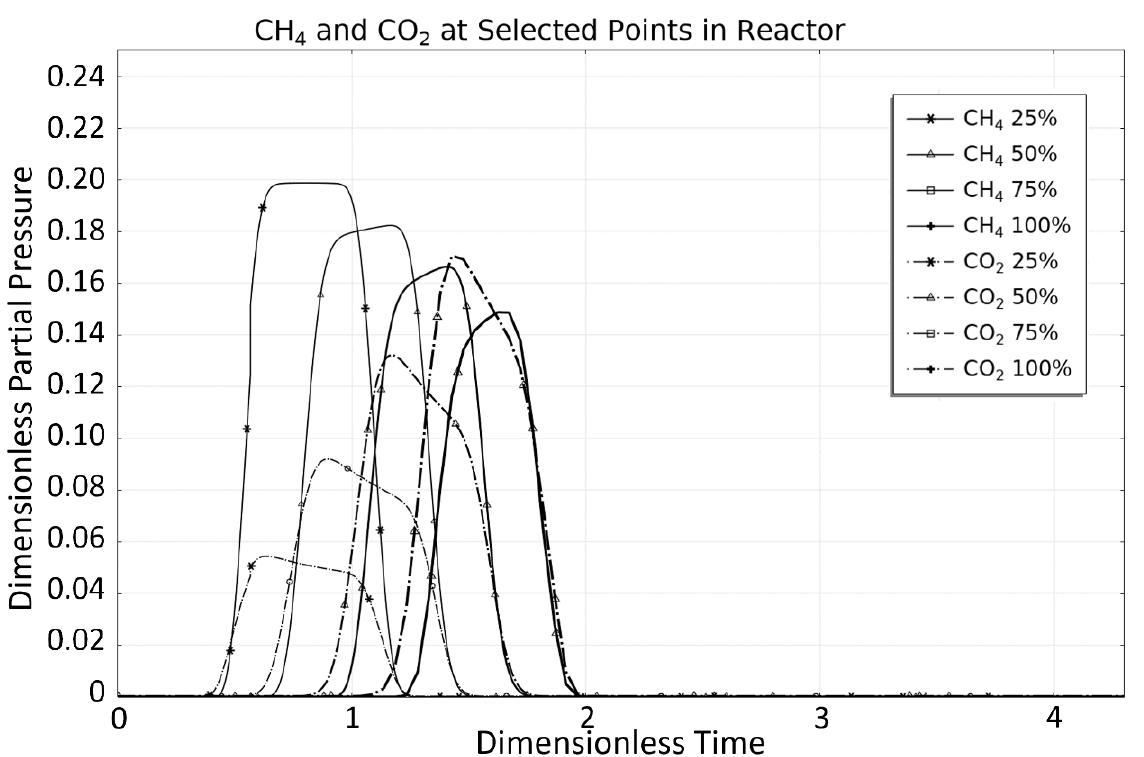
Figure 5. Dimensionless time evolution of H 2 dimensionless partial pressure in void and storage domains at four reactor lengths for the last cycle of Da = 2, Θ = 10.